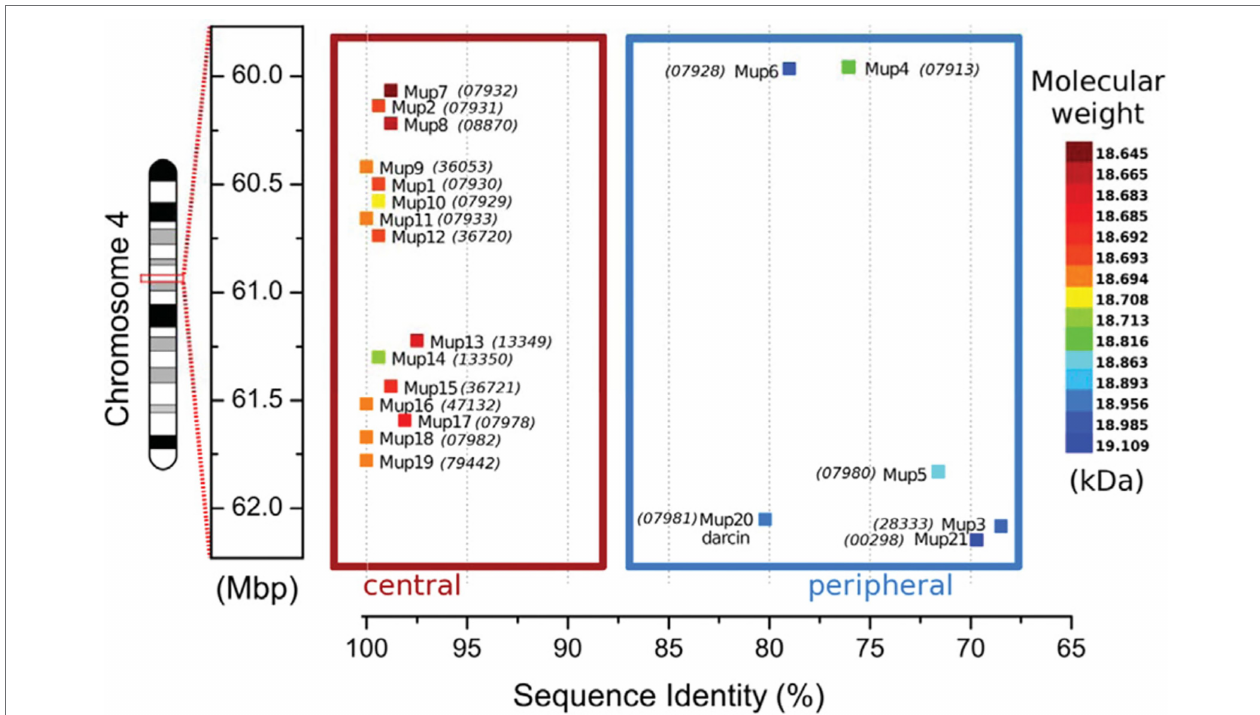
FIGURE 2 | MUP Gene Cluster of House Mice. MUP genes, indicated by colored squares, are closely linked in a large (2 Mb) region on chromosome 4 that contains up to 21 tandemly coding MUP genes and ca . 30 non-coding pseudogenes (Logan et al., 2008; Mudge et al., 2008; Phelan et al., 2014). MUP loci have been classified depending on their location inside of this cluster: the six Class A or “peripheral” MUPs ( Mup3, 4, 5, 6, 20, and 21 , in the blue box) share ca . 88% similarity (“<82% mature protein sequence identity”), and these MUPs are likely more ancestral. The 15 Class B or “central MUPs” (in the red box) are nearly identical and show >97% mature protein sequence similarity and some differ by a single amino acid substitution. These highly homologous MUPs are likely recent duplications (Logan et al., 2008). Class A and B MUPs do not appear to differ in their gene expression levels in the liver (see Figure 4 below). The coloration of the MUP gene corresponds to the molecular weight of the mature protein upon translation. The sequence identity percentage is relative to the most common mature amino acid sequence that is shared by genes Mup9 , 11 , 16 , 18, and 19 . Numbers in parentheses correspond to the MGI protein identification number. All numbers are prefixed with “OTTMUSP000000.” Figure used with permission from Phelan et al.